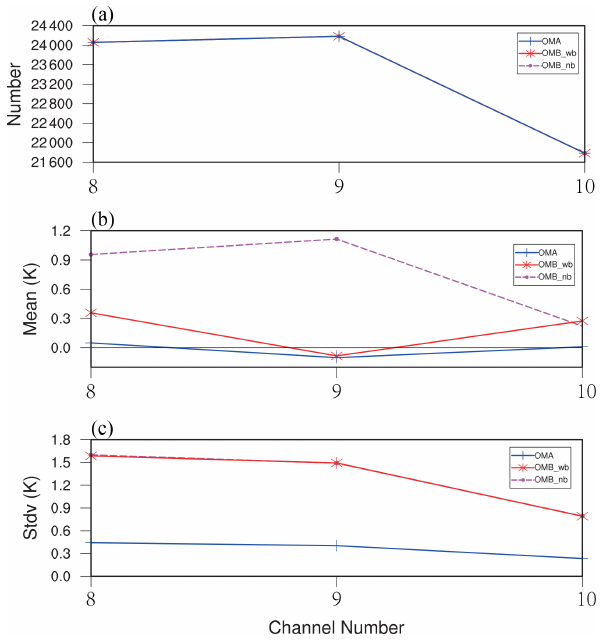
Figure 9. (a) Number of observations, (b) mean (unit: K), and (c) standard deviations (unit: K) of OMB and OMA before and after the bias correction for water vapor channels 8–10 (OMB_nb: OMB without bias correction; OMB_wb: OMB with bias correction).